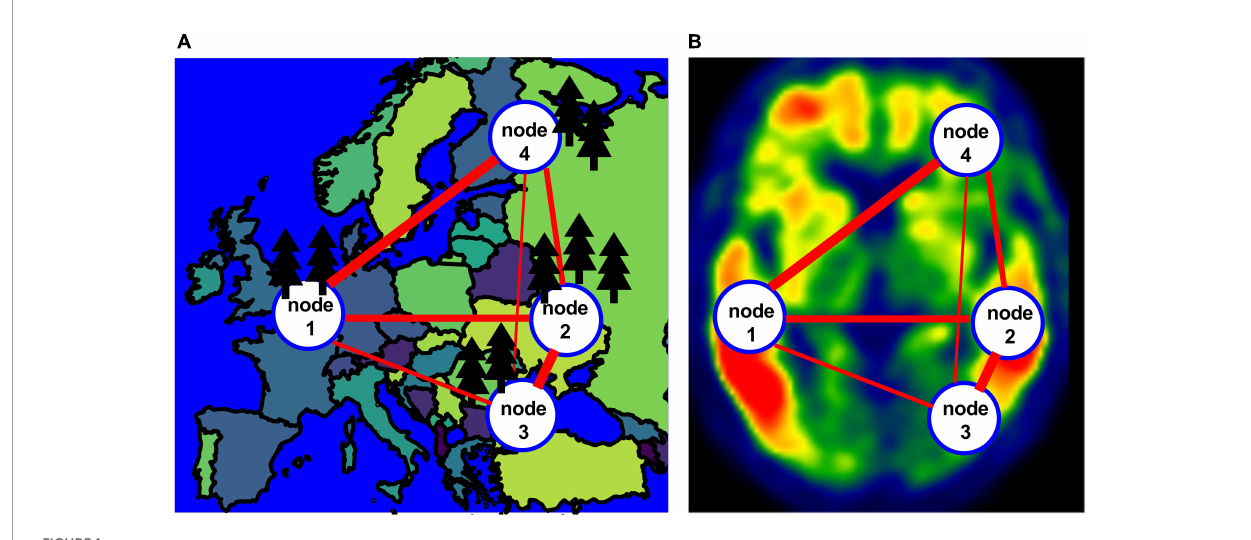
FIGURE1 (A) An example of a population network with four nodes. (B) An example of the network for a tau image.